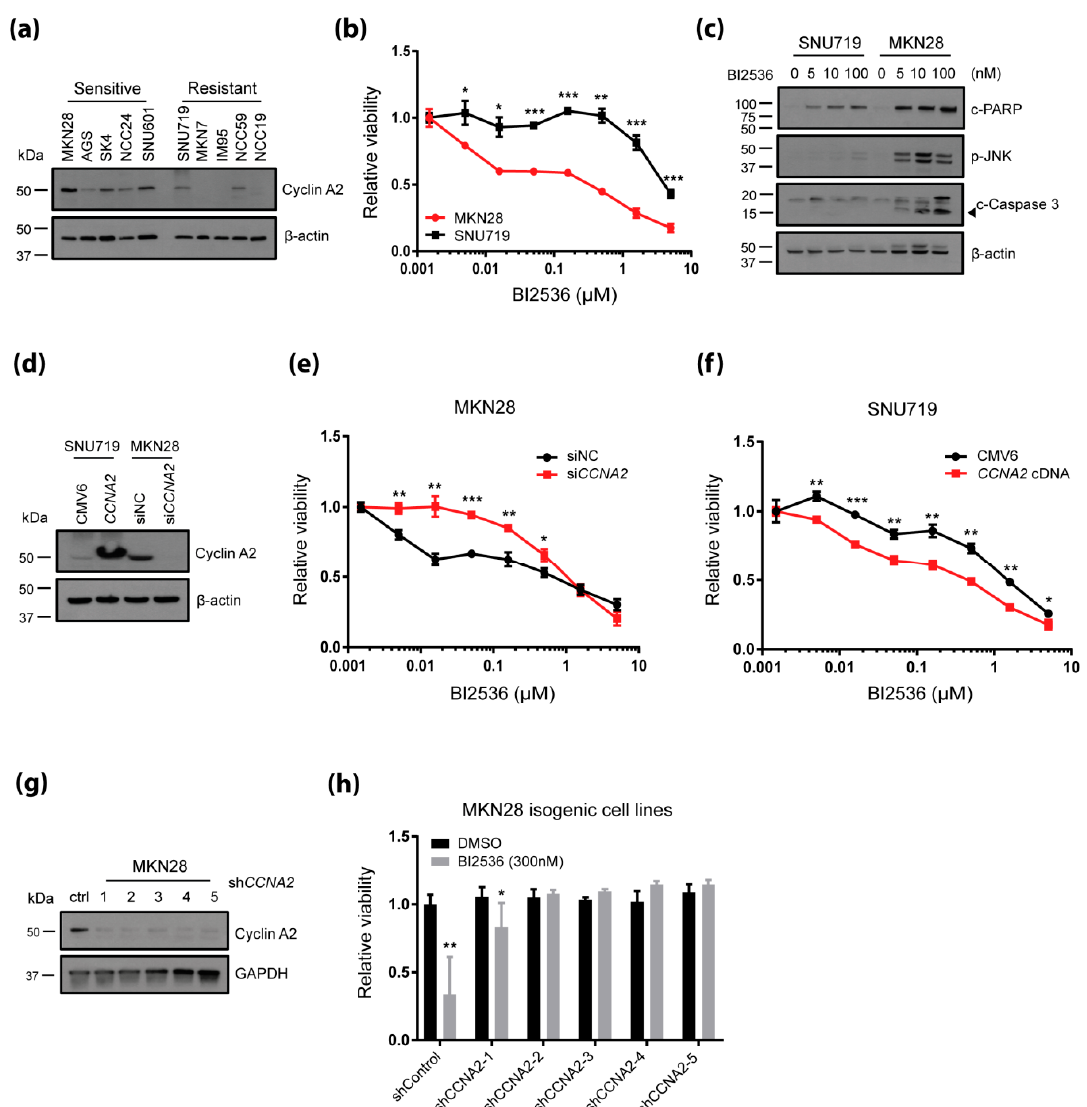
proteins (Figure S4a,b) and observed their e ff ects on BI-2536 sensitivity. Interestingly, overexpression of neither of these mutant PLK1 proteins nor wild-type PLK1 altered sensitivity to BI-2536 (Figure S4c,d), indicating that CCNA2 -induced BI-2536 sensitivity is independent of PLK1 and phospho-PLK1 levels. Cancers 2020 , 12 , x